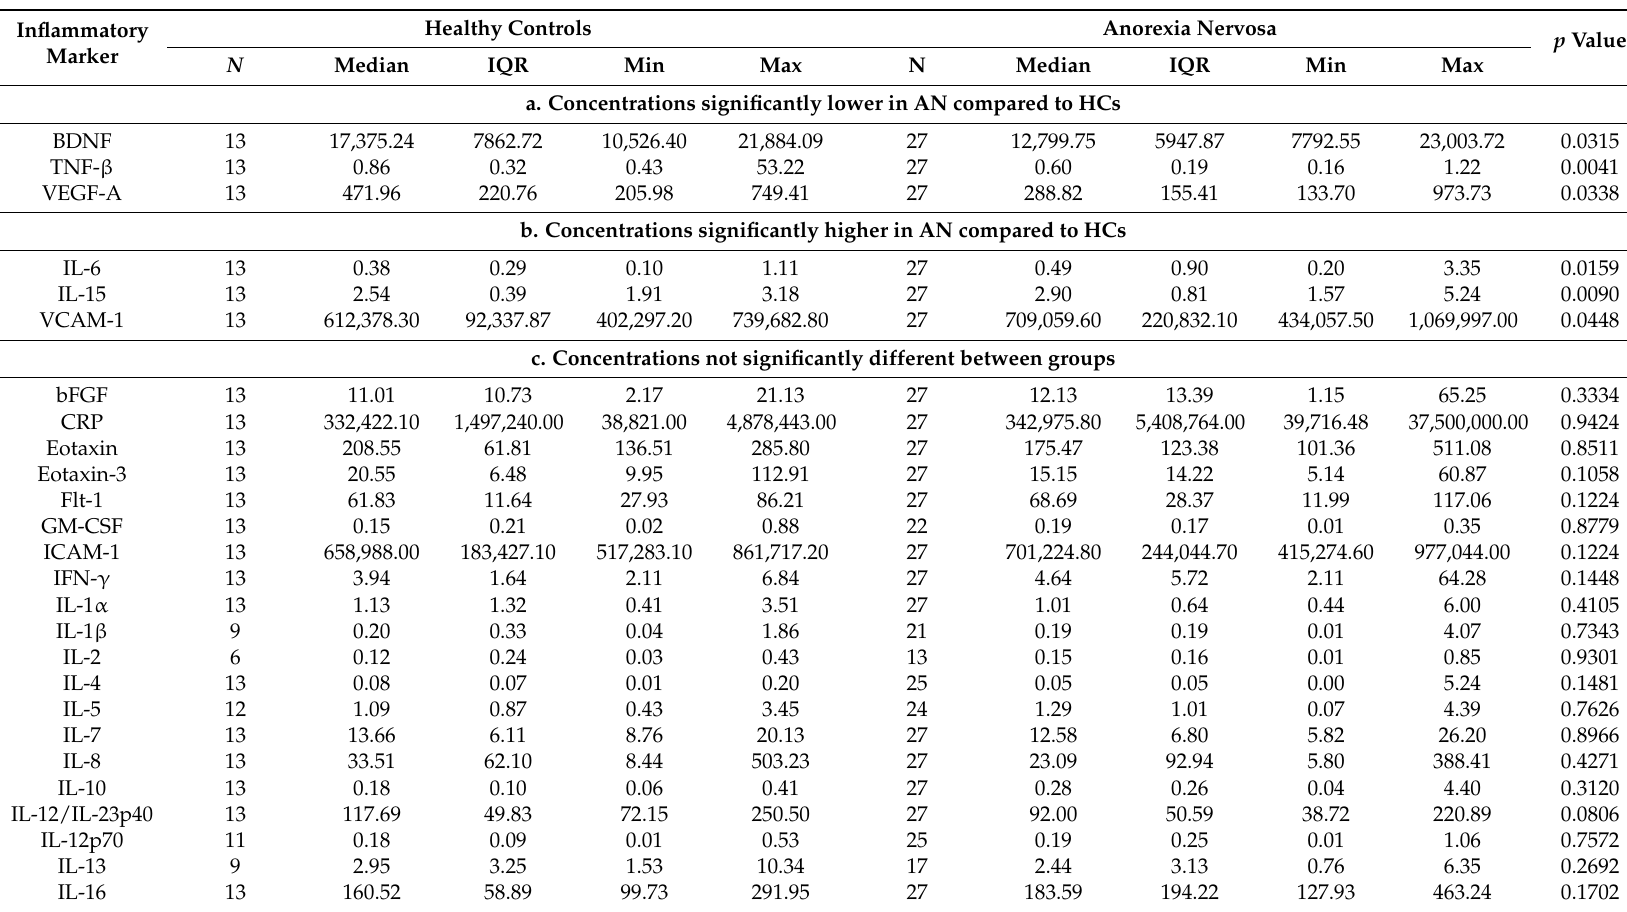
Table 2. Median serum concentrations (pg/mL), with interquartile range (IQR), minimum and maximum values, of inflammatory markers for HCs and AN participants.